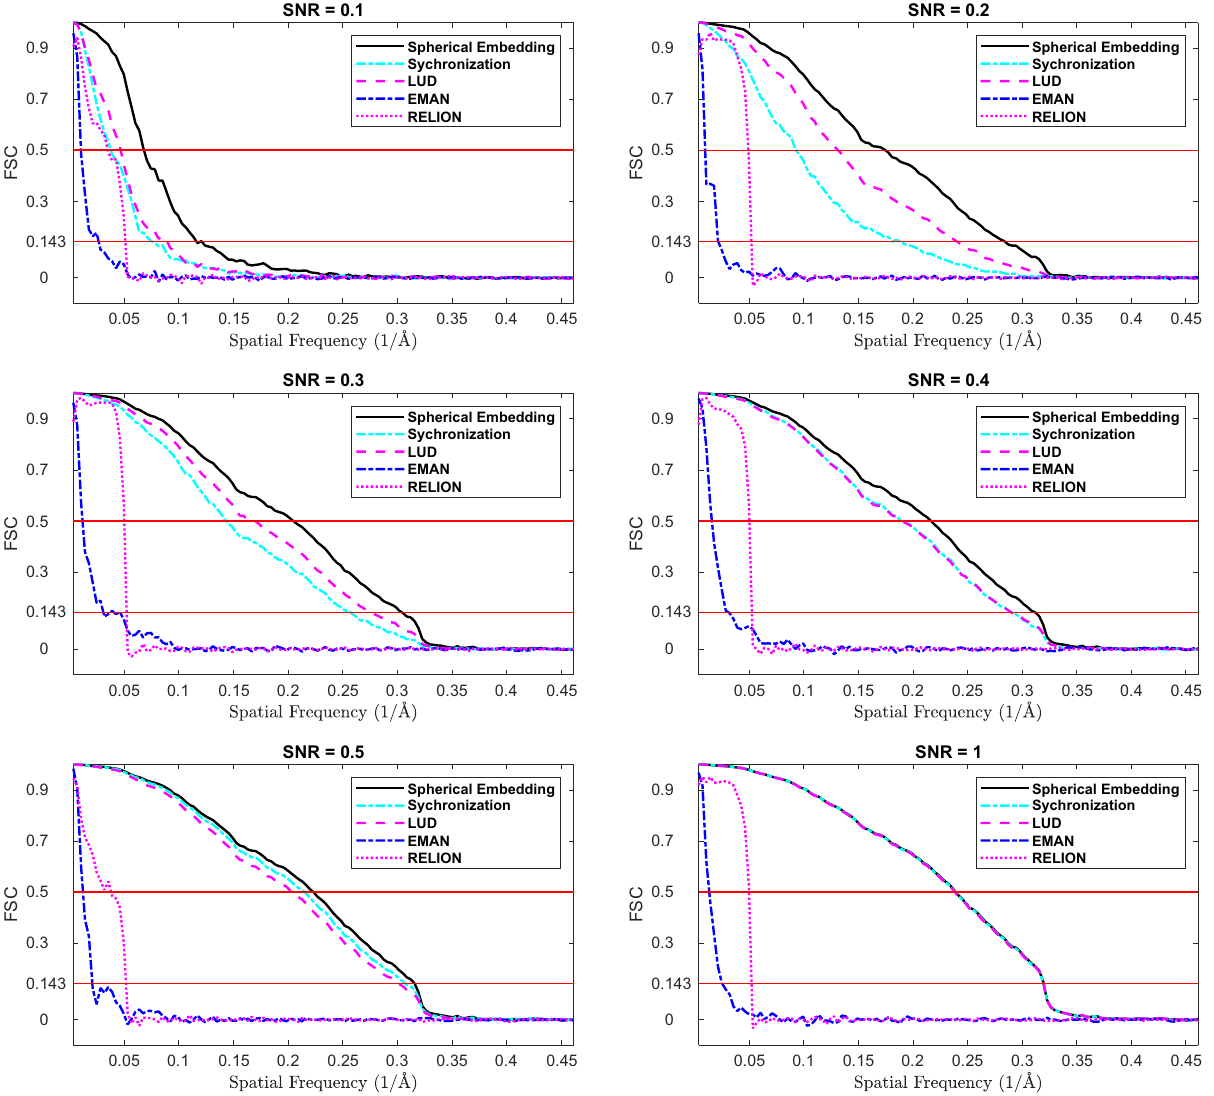
Fig. 3 Comparison of the FSC curves produced at different SNR levels (0.1, 0.2, 0.3, 0.4, 0.5, and 1.0), by the proposed method (Spherical Embedding), Synchronization, LUD, EMAN 2.1, and